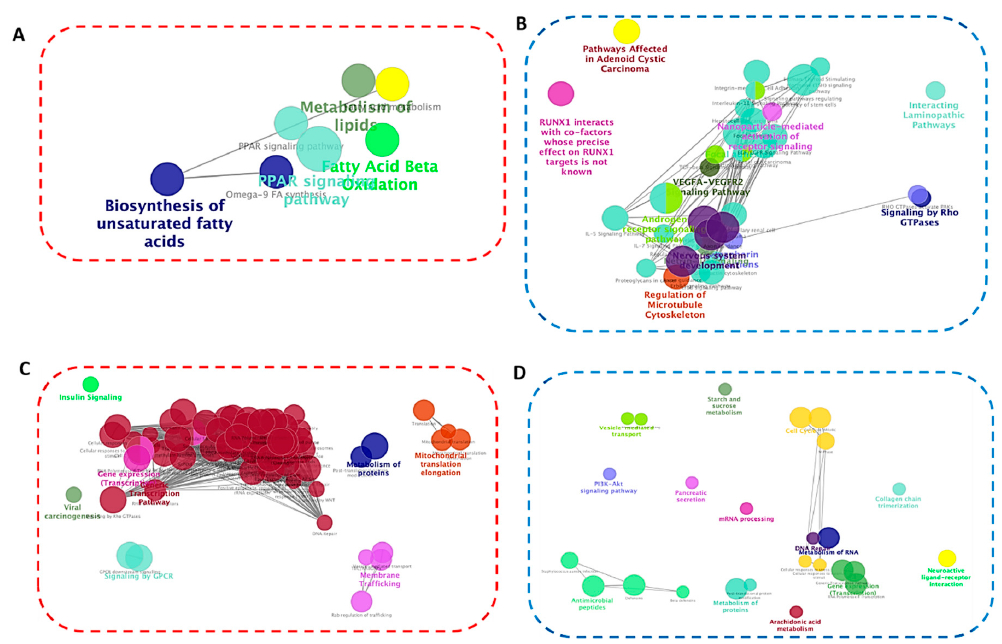
Figure 7. Pathway network analysis based on up- and downregulated DEGs in differentiated SGBS ( A and B , respectively) and 3T3-L1 ( C and D , respectively) adipocytes. The analysis was performed using ClueGO. Enriched pathways were obtained from the KEGG and WikiPathway databases and grouped based on shared genes (ranging from red circle: upregulated to blue circle: downregulated). Size of the nodes indicates degree of significance, where only the most significant term/pathway is labeled as the name of the group. Function-related networks are grouped and may partially overlap.